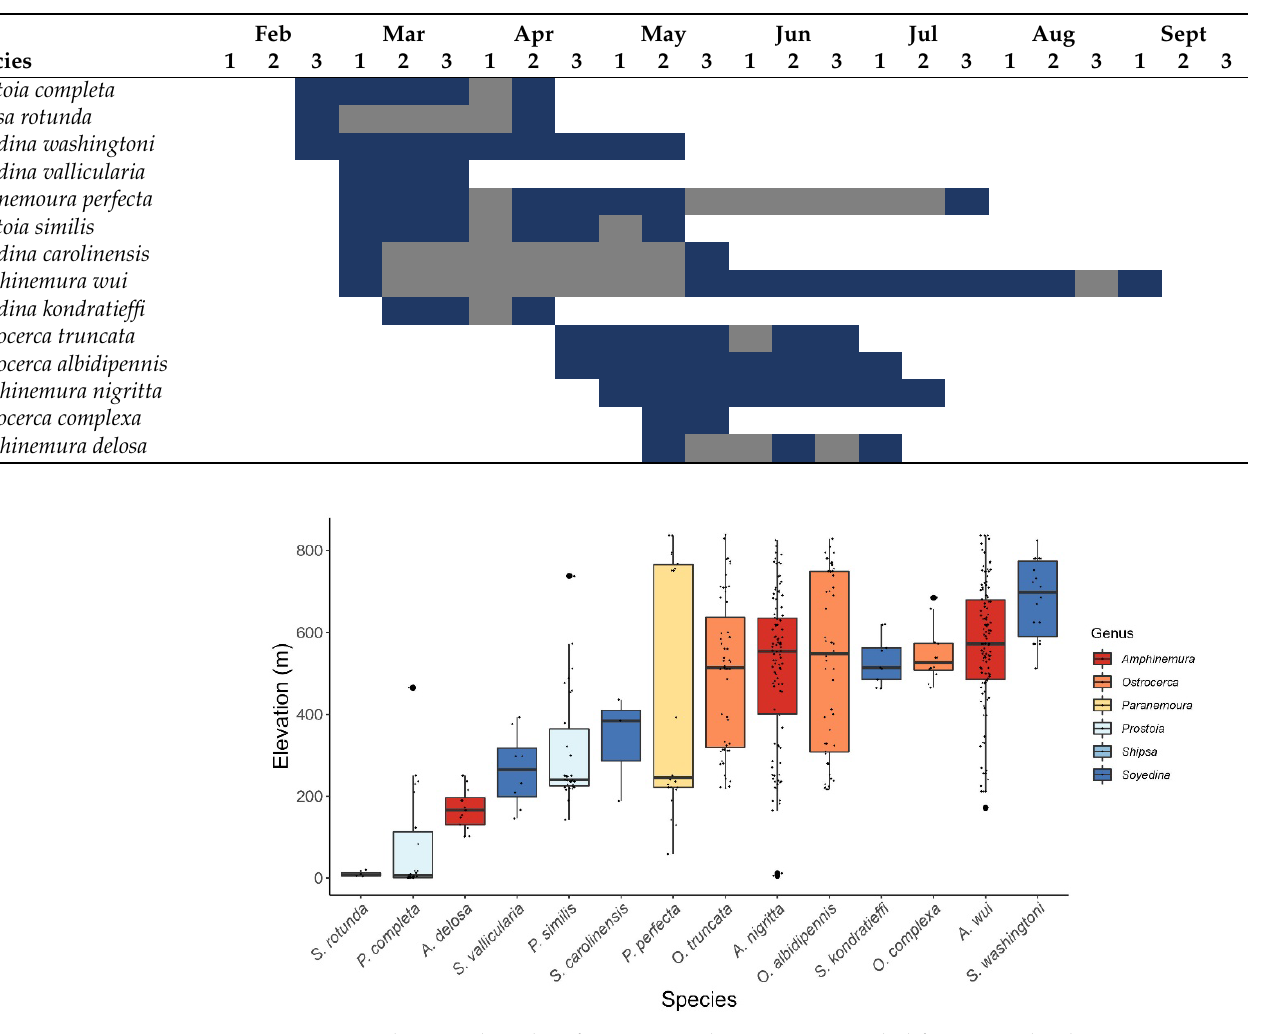
Figure 10. Elevation boxplots for Nemouridae species recorded from Maryland. Boxes represent the